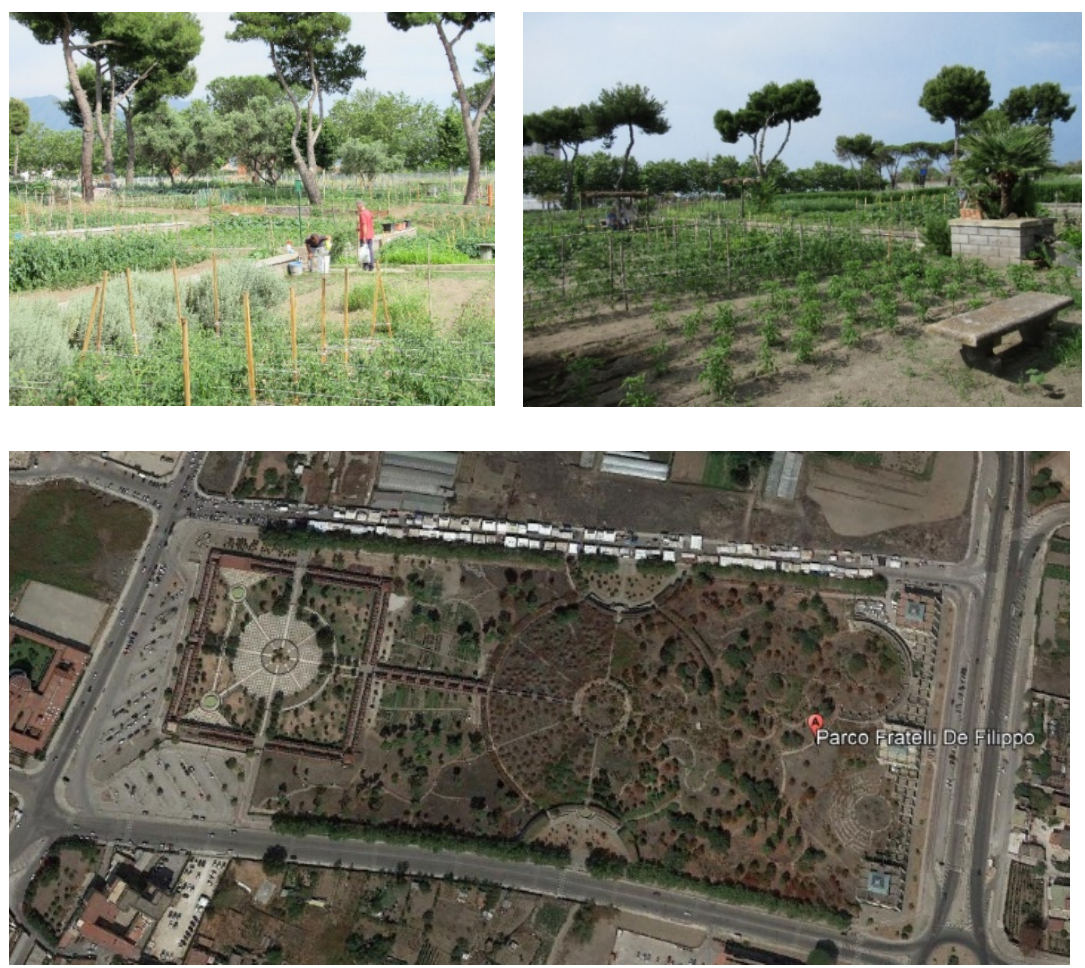
Figure 4. De Filippo park of Ponticelli, Naples. Top—allotment gardens; bottom—aerial view of the park. Source: top—photographs taken by A. Russo on 30 May 2018; bottom—Google Earth